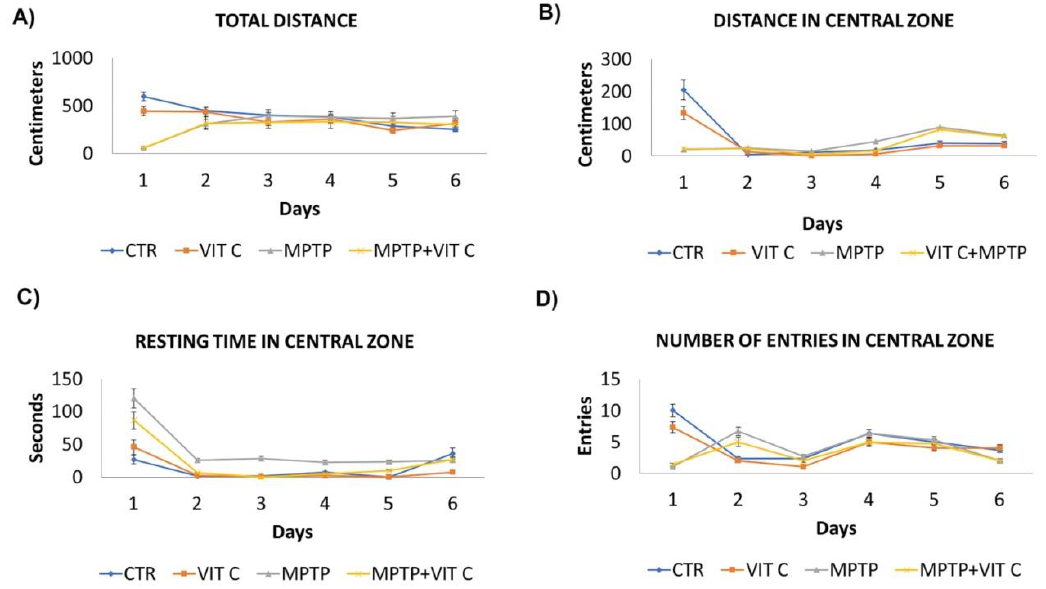
Figure 4. Locomotory and exploratory activity. The data show the total distance traveled ( A ), distance traveled in the central zone ( B ), time spent in central zone ( C ) and number of entries in central zone ( D ) in controls (CTR), mice treated with vitamin C (Vit C), MPTP, MPTP, and Vitamin C (MPTP+Vit C). All values are expressed as means ± SD ( n = 5 per group, 5 replicates, * p < 0.05 MPTP+Vit C vs. Vit C, MPTP vs. CTR).